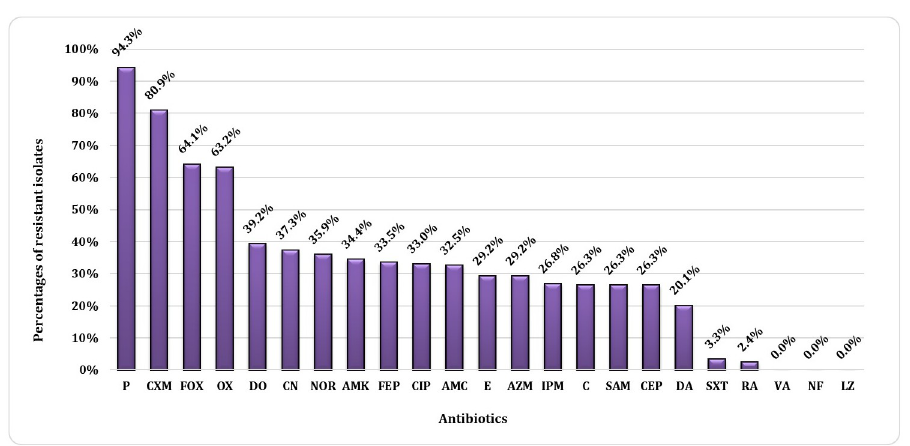
Fig 1. Antibiotic resistance profile of S . aureus isolates. The percentages shown in the figure represent the percentages of the resistant isolates to each tested antibiotic. P, penicillin G; CXM, ceforuxime; FOX, cefoxitin; OX, oxacillin; DO, doxycycline; CN, gentamicin; NOR, norfloxacin; AMK, amikacin; FEP, cefepime; CIP, ciprofloxacin; AMC, amoxicillin / clavulanic acid; E, erythromycin; AZM, azithromycin; IMP, imipenem; C, chloramphenicol; SAM, ampicillin / sulbactam; CFP, cefoperazone; DA, clindamycin; SXT, sulphamethoxazole / trimethoprim; RA, rifampin; VA, vancomycin; NF, nitrofurantoin and LZ, linezolid.